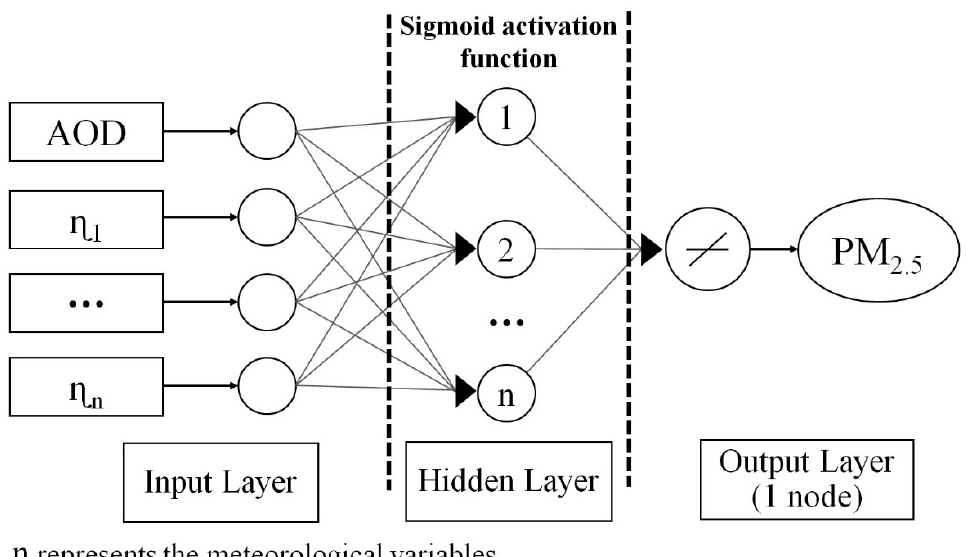
Figure 3. Schematic of the neural network (NN) used in this study for estimation of particulate matter with an aerodynamic diameter of less than or equal to 2.5 µ m (PM 2.5 ).